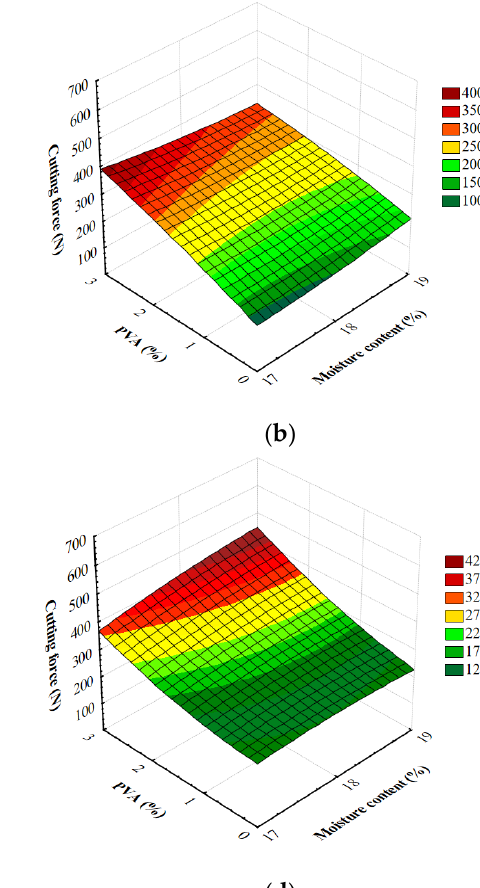
Figure 5. Cutting force of starch foams extrusion with various amounts of PVA and the initial moisture content of raw materials processed with different forming dies at various screw speed: ( a ) M1-S1, ( b ) M1-S2, ( c ) M2-S1 and ( d ) M2-S2.